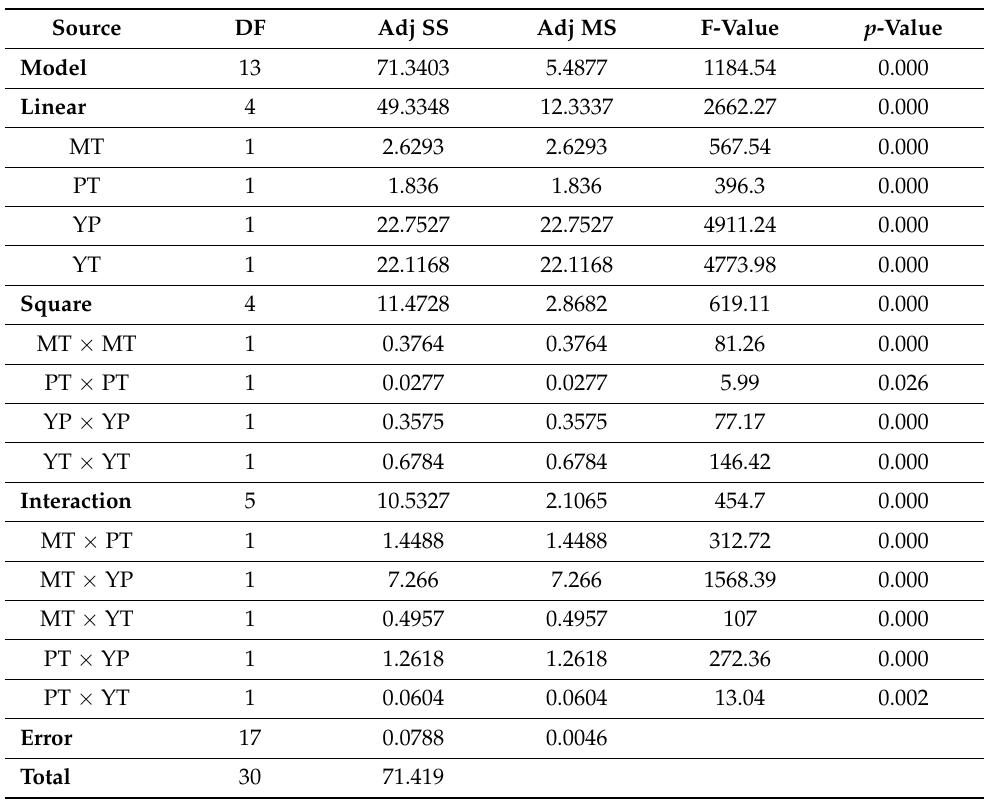
Table 6. Response surface design dispersion analysis.